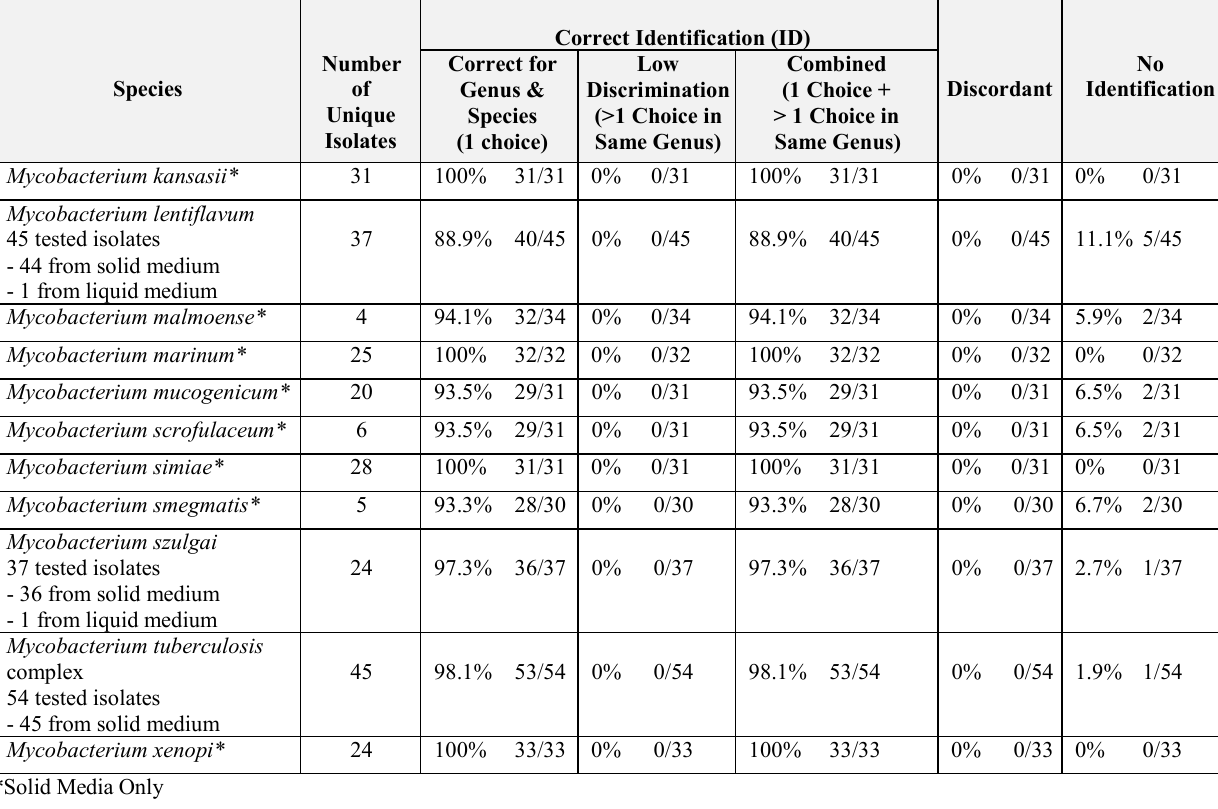
TABLE 15: Nocardia Performance with VITEK MS V3.0 Knowledge Base